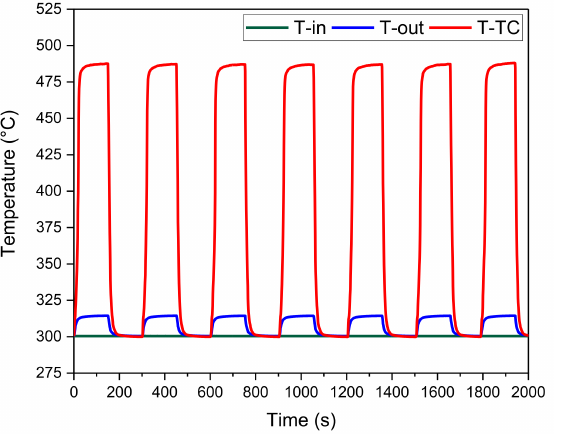
Figure 9. Temperatures (T-in, T-out, T-TC) in 7 cycles for FG mock-up during the run 5 August